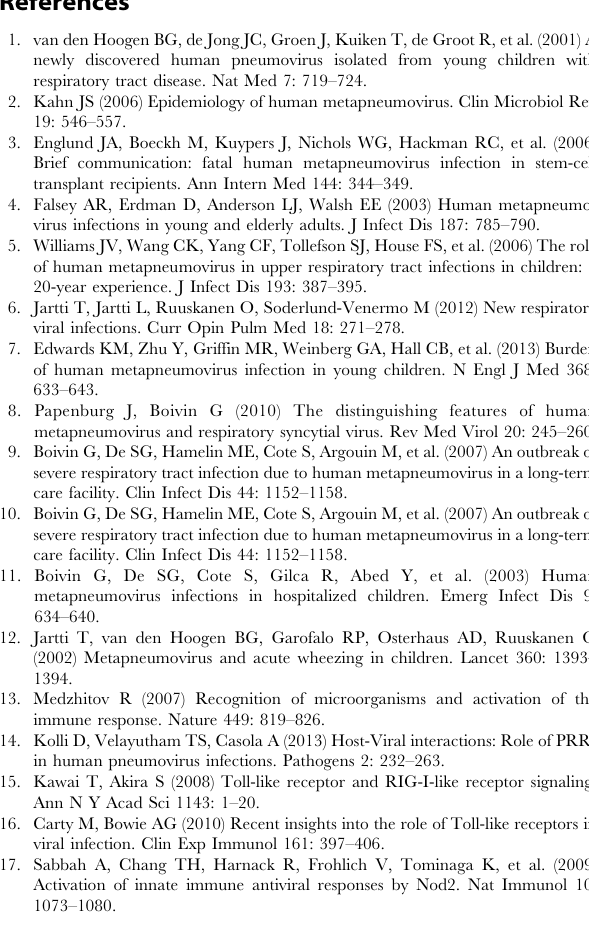
(TIF) Figure S2 Percentage of activated CD4 T cells recruited to the lungs at the peak of T cell infiltration. TLR4 2 / 2 and WT mice were infected with hMPV or mock-infected, and sacrificed at day 8 p.i. to collect lungs. Cells isolated from lungs were stained with anti-CD3, -CD4, and -CD69 antibodies and analyzed by flow cytometry to determine expression of CD69 which is represented as percentage of CD4 + T cells. Graph represents mean 6 SEM of four mice/group. * P , 0.05 when comparing CD4 + T cells isolated from hMPV infected TLR4 2 / 2 mice versus WT mice.